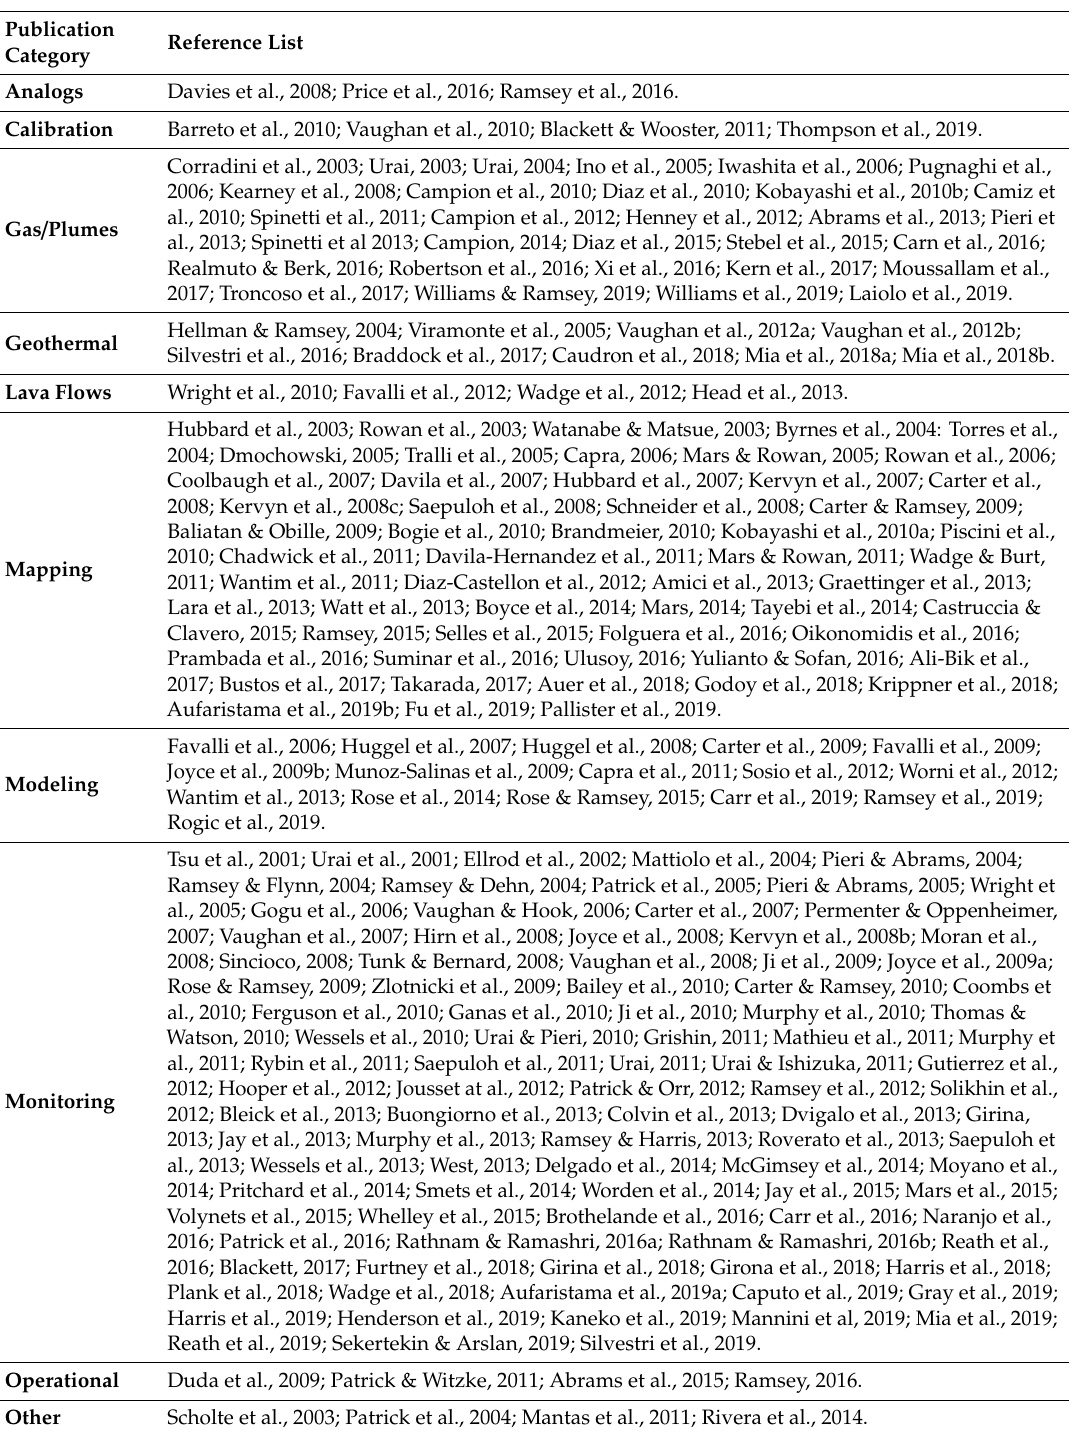
Table A1. Reference list of 271 volcanological publications that use, contain, or make mention of (in the case of the Precursory category) ASTER data. The list spans 25 years, from 1995 to 2019, and is subdivided by category with references therein listed in chronological order. The full citations appear